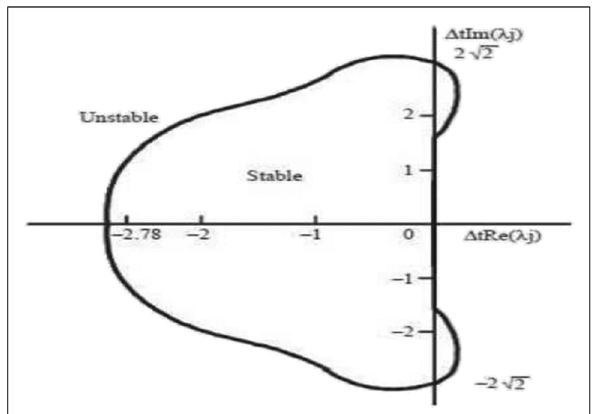
Figure 19: Stability